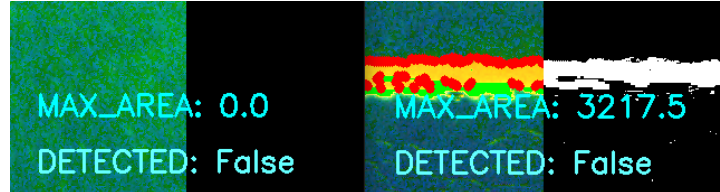
Figure 5. Filtration to detect yellow